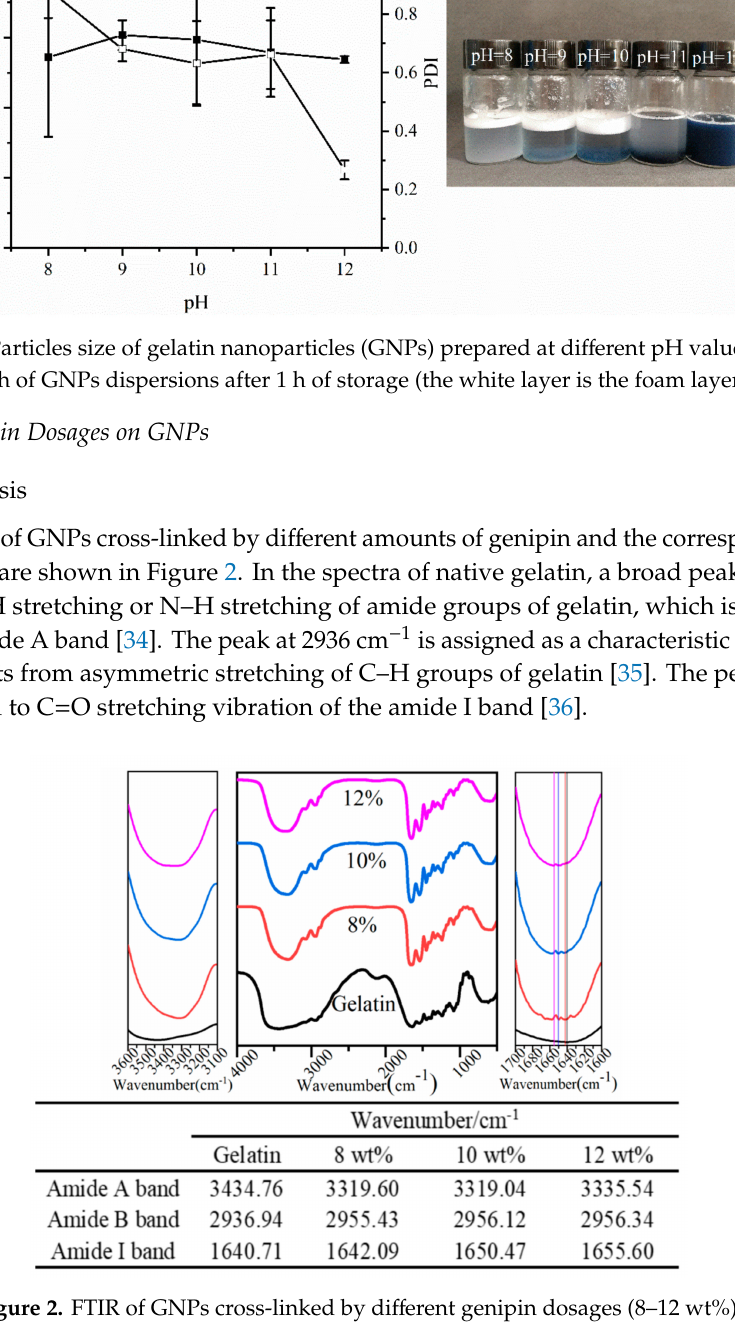
Figure 2. FTIR of GNPs cross-linked by di ff erent genipin dosages (8–12